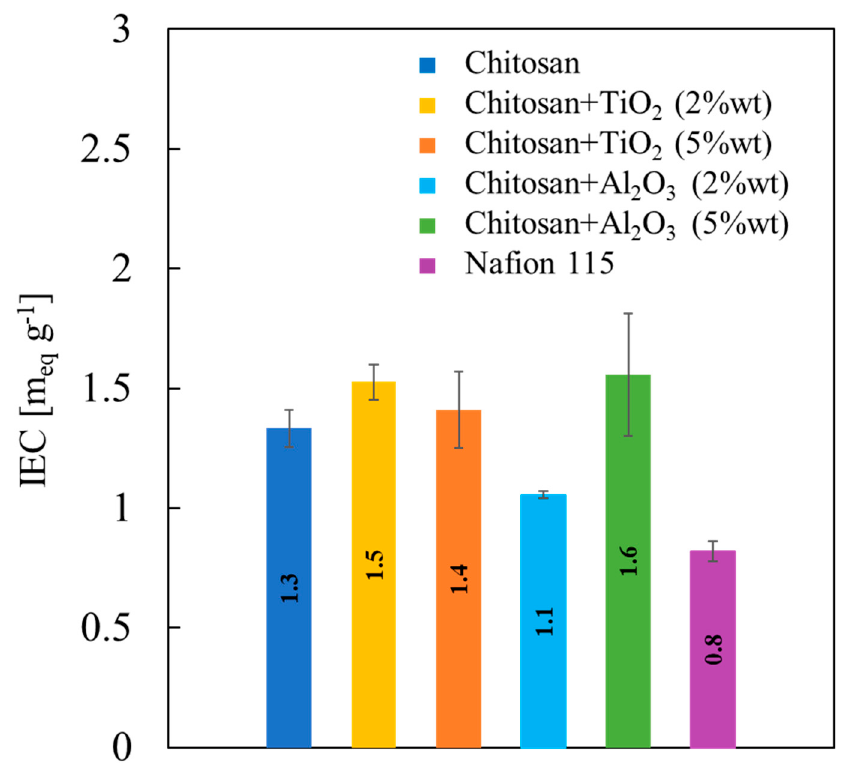
Figure 7. Ion exchange capacity values, estimated according to Equation (3), as a function of properties of all the synthesized membranes.